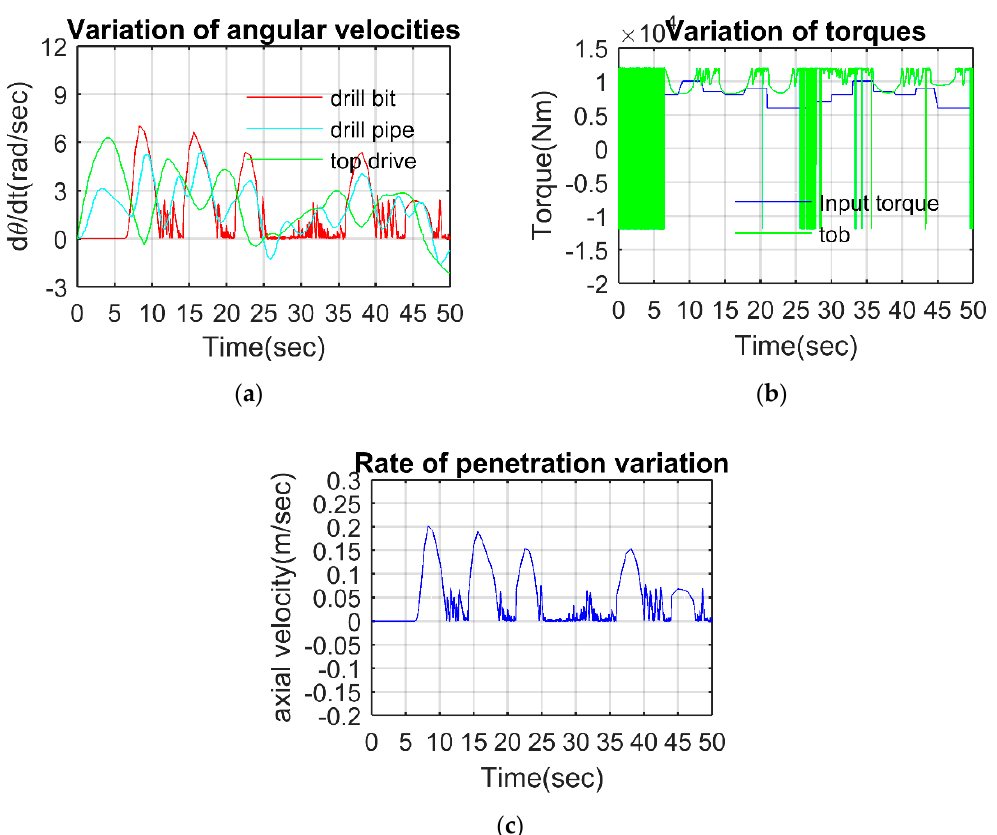
Figure 9. Results of system responses for second scenario: ( a ) angular velocities, ( b ) Tob, ( c ) ROP.